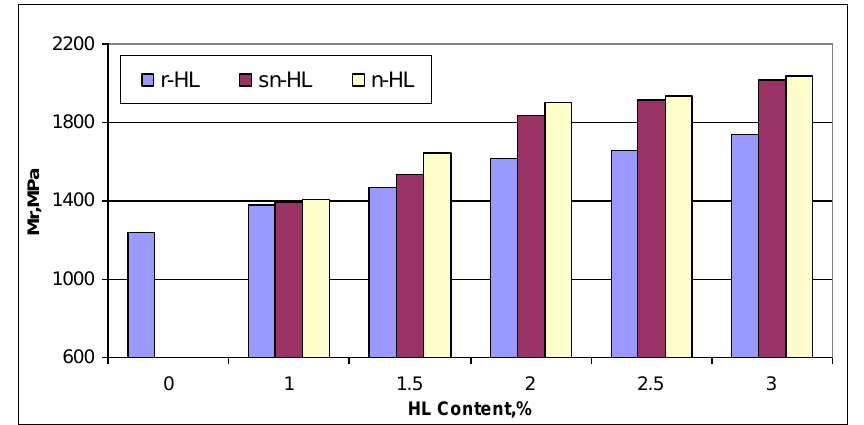
Figure 15. Comparison of the resilient modulus.